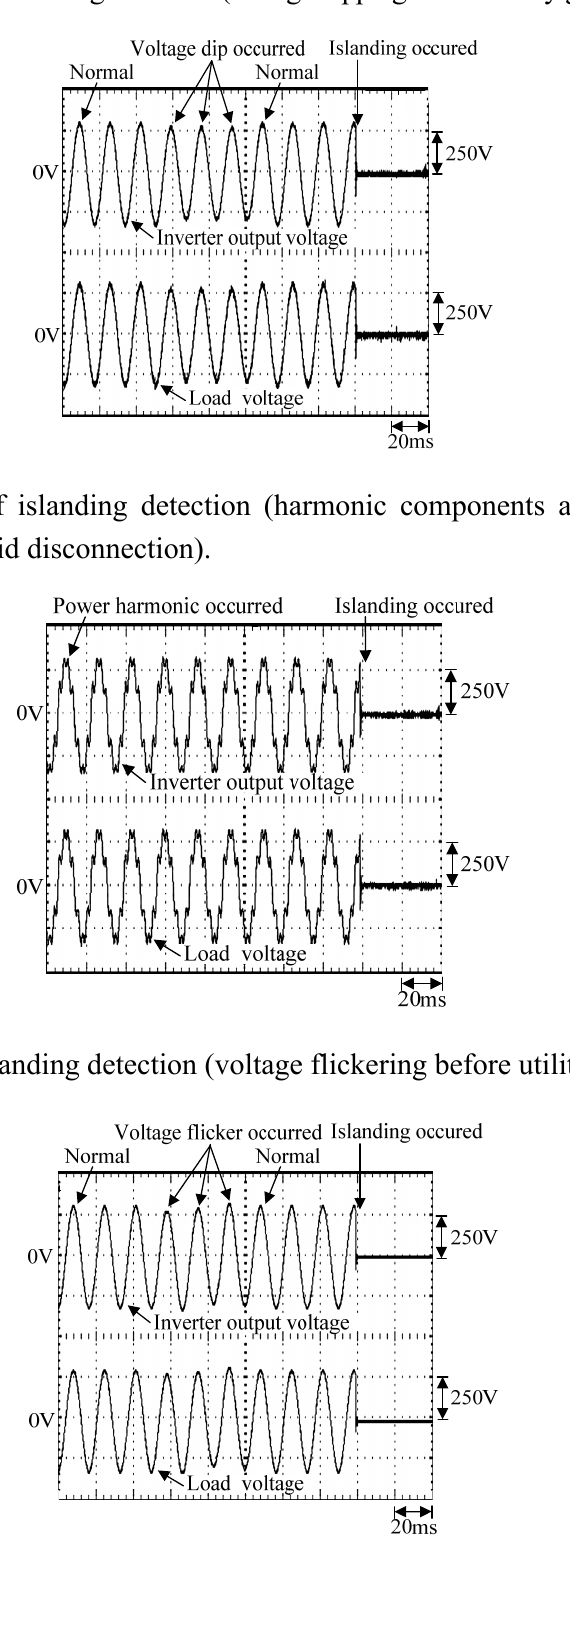
Figure 11. Diagram of islanding detection (voltage dipping before utility grid disconnection).